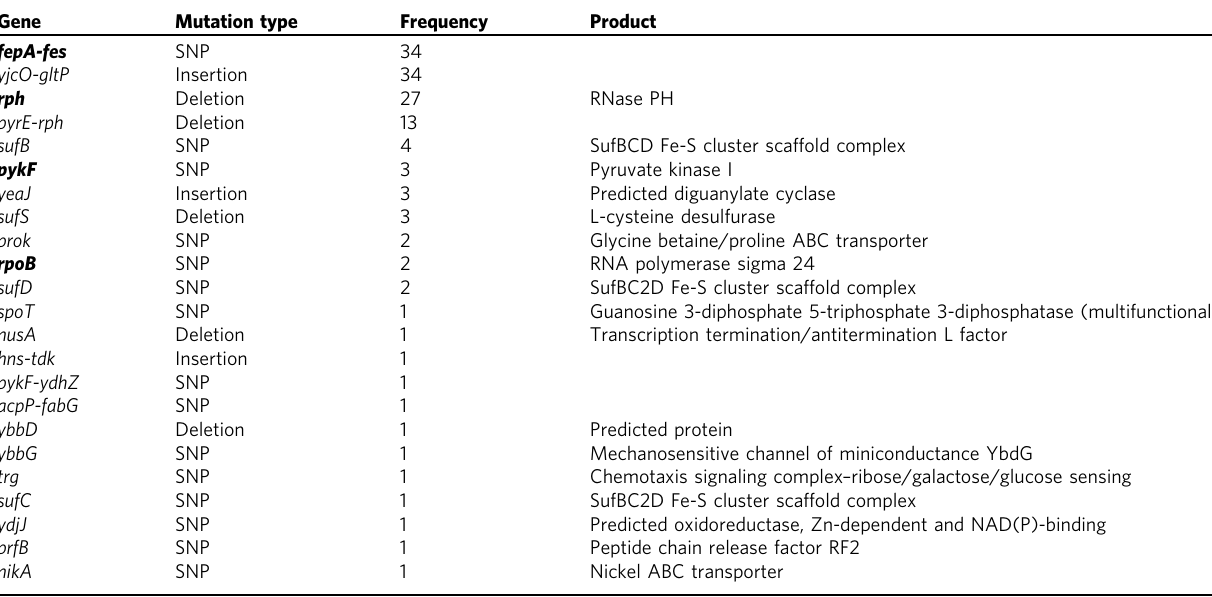
Table 2 Mutations discovered in 35 E. coli isolates under osmotic pressure Gene Mutation